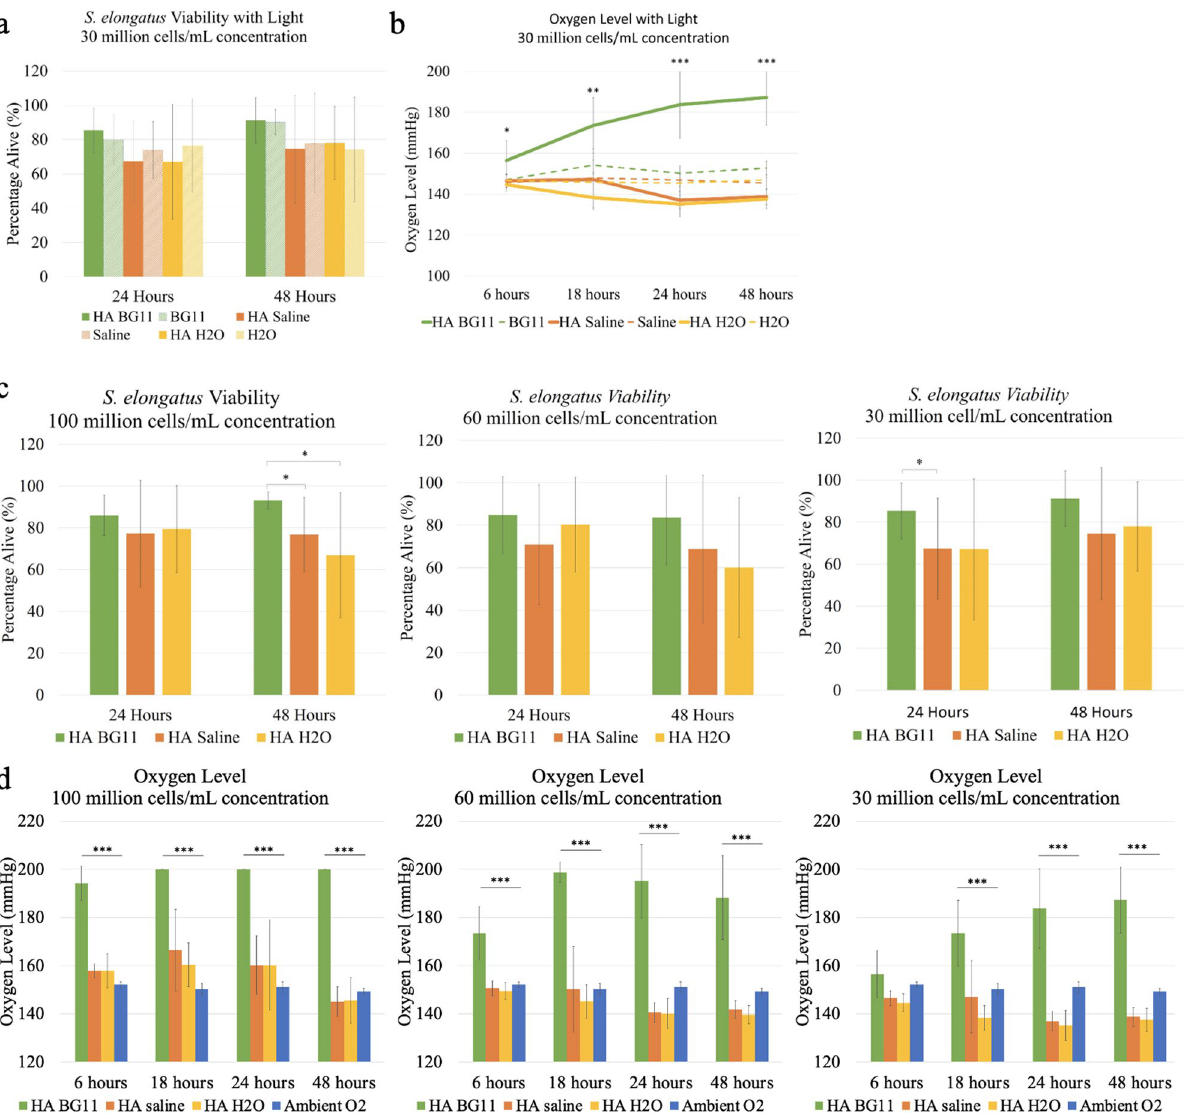
Figure 1. Effect of hyaluronic acid on S. elongatus viability and oxygen production with light exposure. ( a ) S. elongatus viability at 30 million cells/mL in BG11 medium, normal saline, and H 2 O with and without hyaluronic acid were similar between the groups and after 24 compared to 48 h of incubation. Statistical analyses were performed using the student t test. ( b ) At 30 million cells/mL, hyaluronic acid gel in BG11 with S. elongatus under light incubation was associated with the highest oxygen level at 6, 18, 24, and 48 h compared to the other groups. Hyaluronic acid gel in BG11 compared to BG11 only with S. elongatus, was associated with significantly higher oxygen level at all time points based on post-hoc correction (p < 0.009). The addition of hyaluronic acid to normal saline or water was associated with lower oxygen level at 18, 24, and 48 h (p < 0.004 and p < 0.002, respectively) based on post-hoc correction. Statistical analyses shown in the figure were performed using the analysis of variance at each time point. ( c ) S. elongatus viability at 30, 60, or 100 million cells/mL concentration remained similar within the same gel composition at 24 and 48 h. S. elongatus viability was generally higher when incubated in the hyaluronic acid in BG11 compared to other gel compositions. Statistical analyses were performed using the student t test. ( d ) Oxygen production was consistently higher in the hyaluronic acid gel in BG11 at 30, 60, and 100 million cells/mL concentration compared to hyaluronic acid in normal saline (p < 0.007, p < 0.0001, and p < 0.0001, respectively) and hyaluronic acid in water (p < 0.002, p < 0.0001, and p < 0.0001, respectively) based on post-hoc correction. Data presented as mean ± standard deviation. A total of 10 samples were tested for each gel composition for each treatment at each time point. Statistics shown in ( d ) were resulted from the analysis of variance. * Indicates p < 0.05, ** indicates p < 0.01, and *** indicates p <